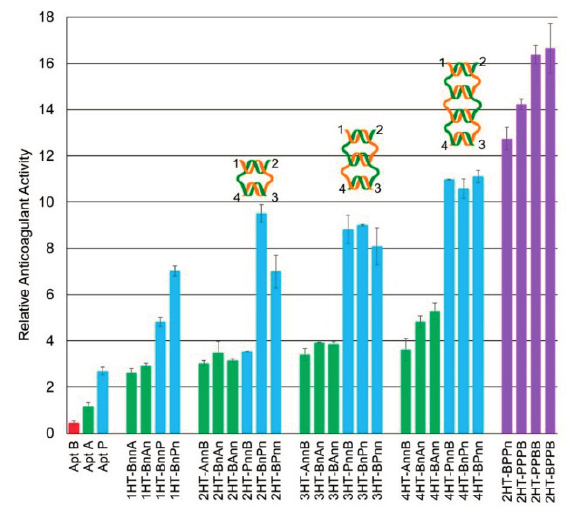
Figure 5. Relative anticoagulant activity of weave tile constructs. Weave tiles with B-P aptamer pairs (blue) demonstrate much better anticoagulant activity compared to those with B-A pairs (green). Activity increases with tile size, except for 2HT-BnPn which shows better activity than 3HT-BnPn. Incorporating multiple copies of Apt P on 2HT-BnPn improves anticoagulation due to higher local concentration (purple). However, incorporating multiple copies of both Apt P and B yields the most effective anticoagulants in 2HT-PPBB and 2HT-BPPB. Weave tile construct names bear a 4-tuple that provides the aptamer identity or “n” for no aptamer for each of the four numbered strand ends (a more thorough explanation of this nomenclature is provided in Section 4.2). Relative anticoagulant activity is calculated as described in Materials and Methods. Error bars represent SEM. Raw clotting times are provided in the Supplementary Materials (Table S2). Relative anticoagulant activity of free aptamer samples is shown for Apt B (red), Apt A (green) and Apt P